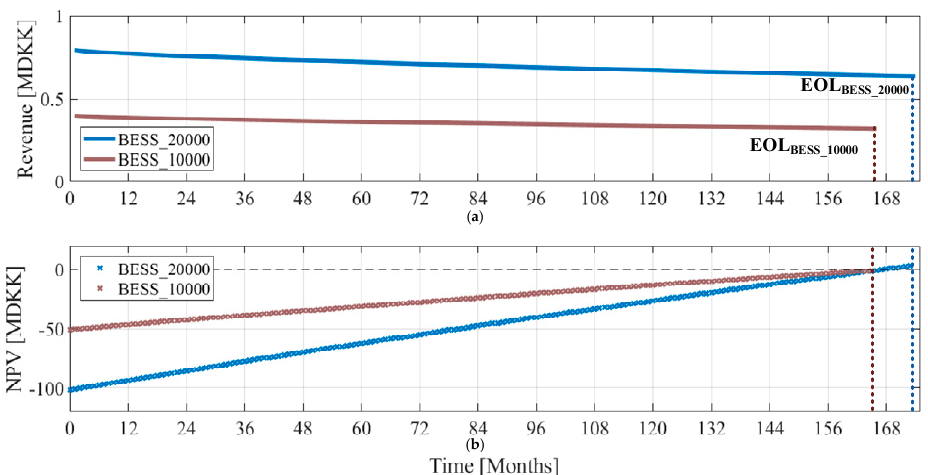
Figure 12. Results of the economic analysis: ( a ) Revenue, ( b ) NPV.